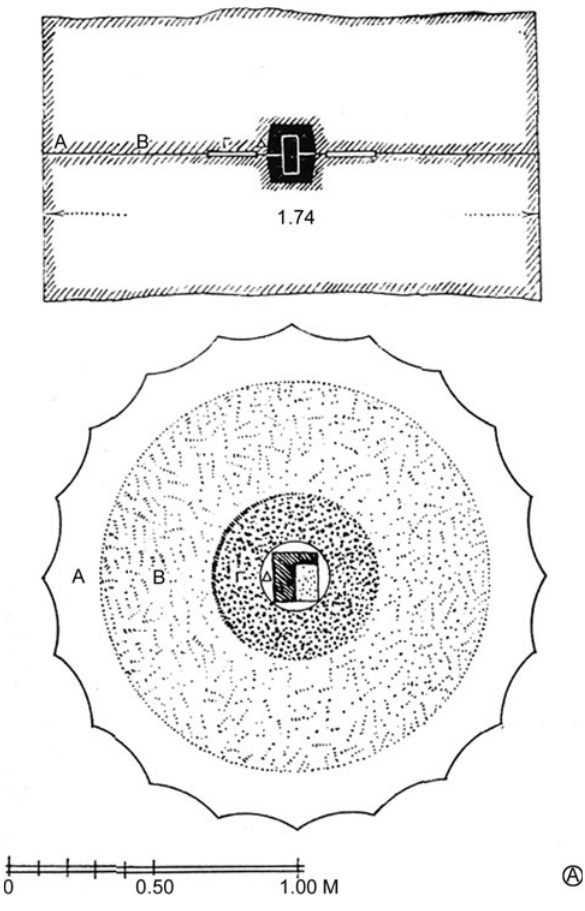
Figure 1 Schematic confi guration of a Parthenon column drum base in plan and